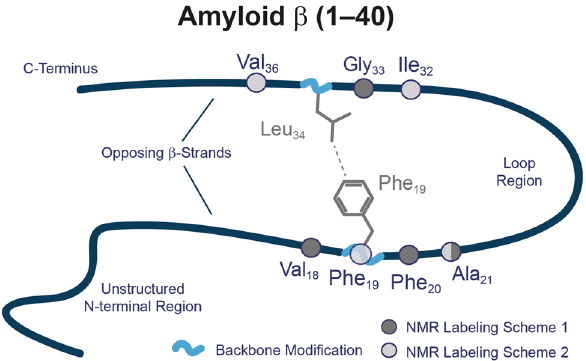
Figure 1. Schematic depiction of the Aβ 40 structure visualizing the backbone modifications (light blue waves) introduced and the NMR labeling schemes applied. From the N-terminus, the peptide fibrils feature an unstructured N-terminus continue with β-strand 1 which ends at the beginning of the loop region, followed by β-strand 2 and the C-terminus. Both β-strands oppose each other with the side chains of the respective amino acids interacting in a steric-zipper motif. We targeted the hydrophobic contact between Phe 19 and Leu 34 by introduction of backbone modifications, namely methylene or ethylene spacer or N -methylation of the amide, in both residues in different combinations (see Fig. 2). Two isotopic labeling schemes (light and dark gray spheres) were applied for the investigations of local structure and dynamics of Aβ 40 fibrils by solid-state